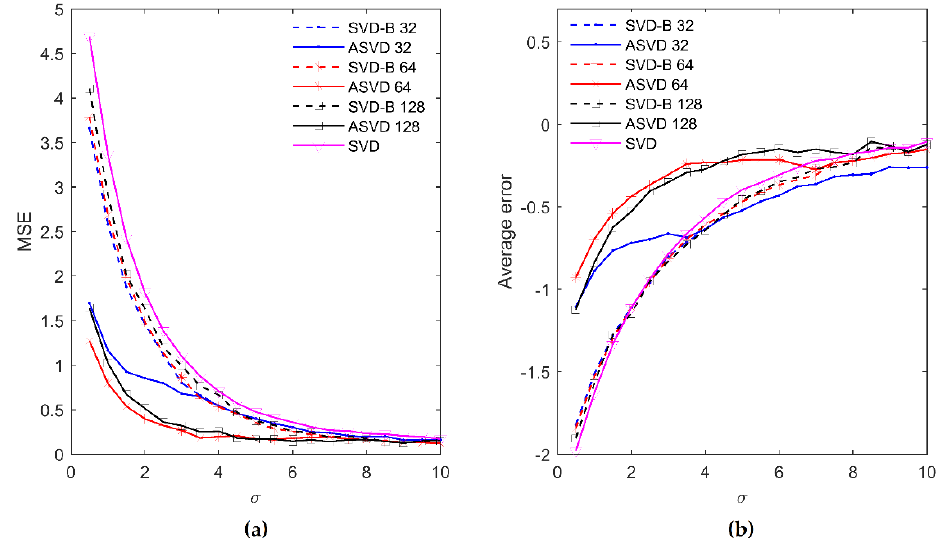
Figure 7. ( a ) MSE across noise levels; ( b ) Average error across noise levels.